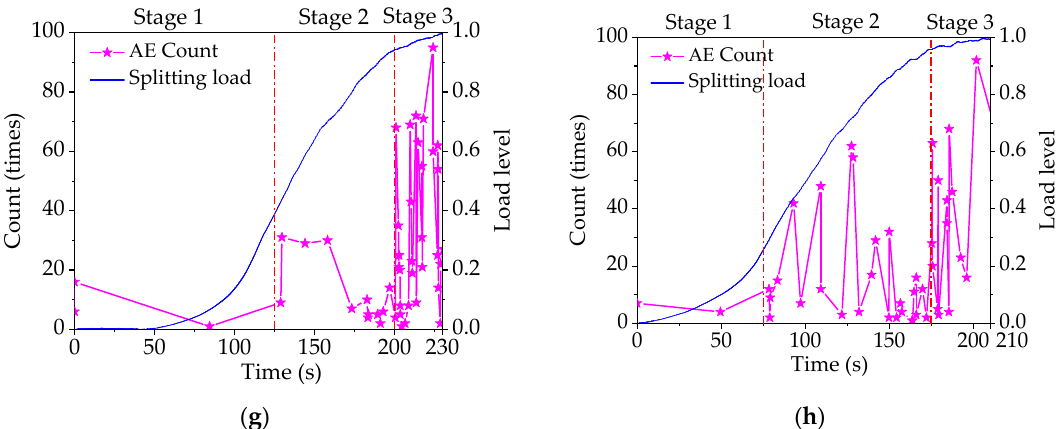
Figure 9. The AE count and load level versus time during splitting at − 10 ◦ C for SBS-modified asphalt mixture with basalt fiber under various F-T cycles. ( a ) 0 F-T cycle; ( b ) 3 F-T cycles; ( c ) 6 F-T cycles; ( d ) 9 F-T cycles; ( e ) 12 F-T cycles; ( f ) 15 F-T cycles; ( g ) 18 F-T cycles; and ( h ) 21 F-T